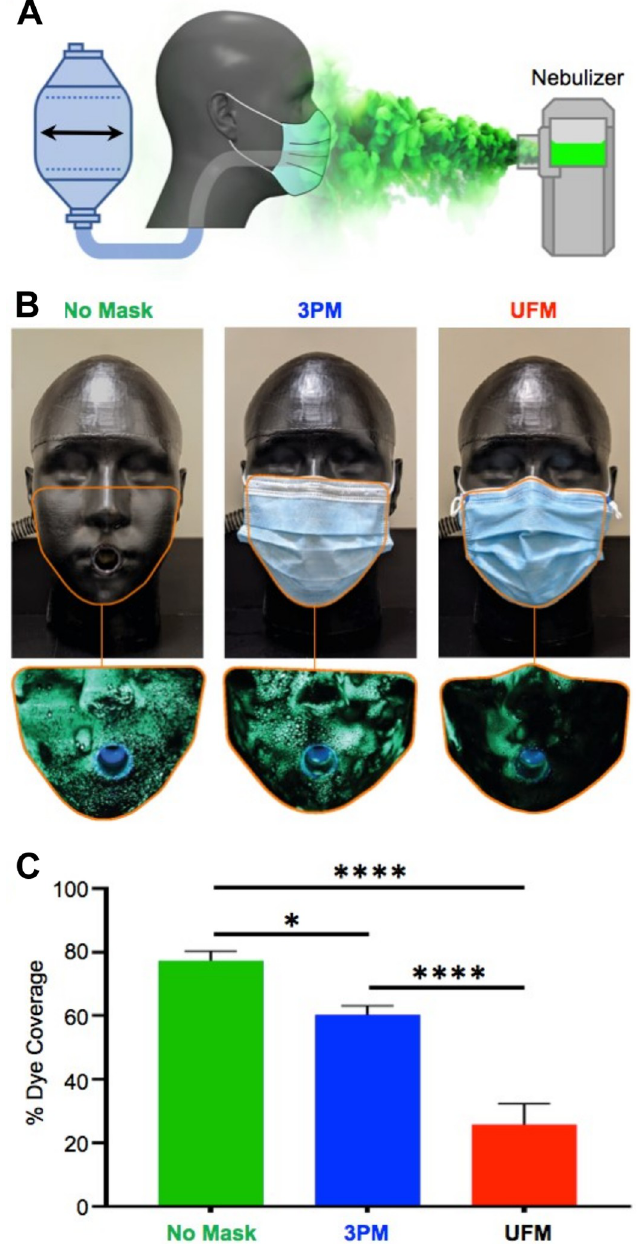
Fig 4. Aerosol dye examination of 3PM and UFM. (A) Schematic of the experimental setup where an aerosolized fluorescent dye was nebulized in the vicinity of the headform, with exhalation and inhalation breathing simulated by a modified resuscitator. (B) Fluorescent droplets deposited on a NIOSH medium headform with no mask, 3PM, and UFM. For scale, each image measures ca. 18 cm wide. A lower percentage of dye coverage indicates improved protection from external aerosol droplets. (C) Relative exposure of the mannequin to aerosols assessed by the relative area covered by aerosolized fluorescent dye. Results represent the mean ± SD of 6 repeated trials. � and ���� indicate adjusted P < 0.05 and P < 0.0001 compared via a one-way ANOVA with Tukey post-hoc test.